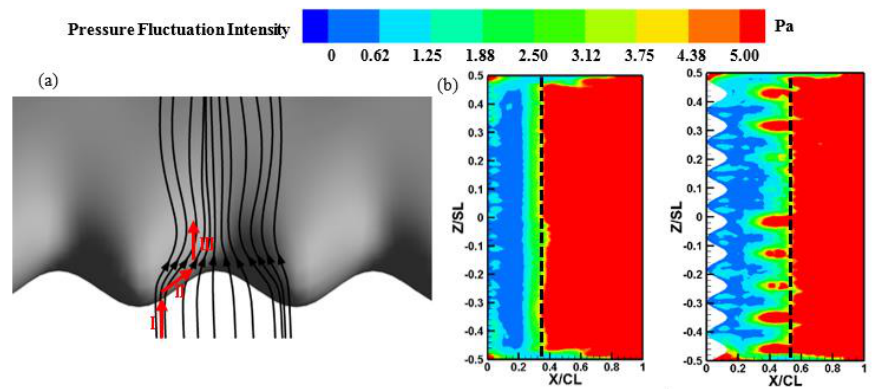
Figure 17. Streamlines and pressure fluctuation intensity. ( a ) Streamlines; ( b ) Pressure fluctuation intensity.